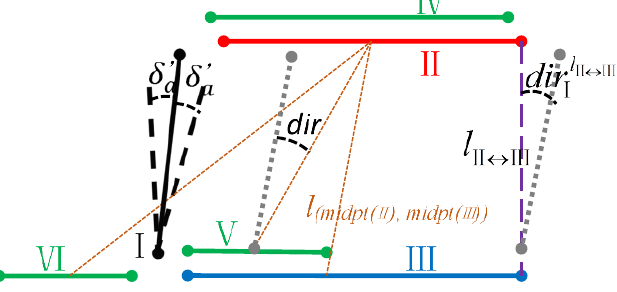
Figure 7. Producing the candidate subsets. Segment II is belongs to set A I , and the procedure is to judge whether a relevant subset that includes II exists or not. Segment IV is disregarded because it is close to the same endpoint. Segment V is excluded because of its overlarge angular deviation, and Segment V is rejected for intersection judgment. Segment III remains for weight calculation according to the imaginary edge l  Ⅱ Ⅲ